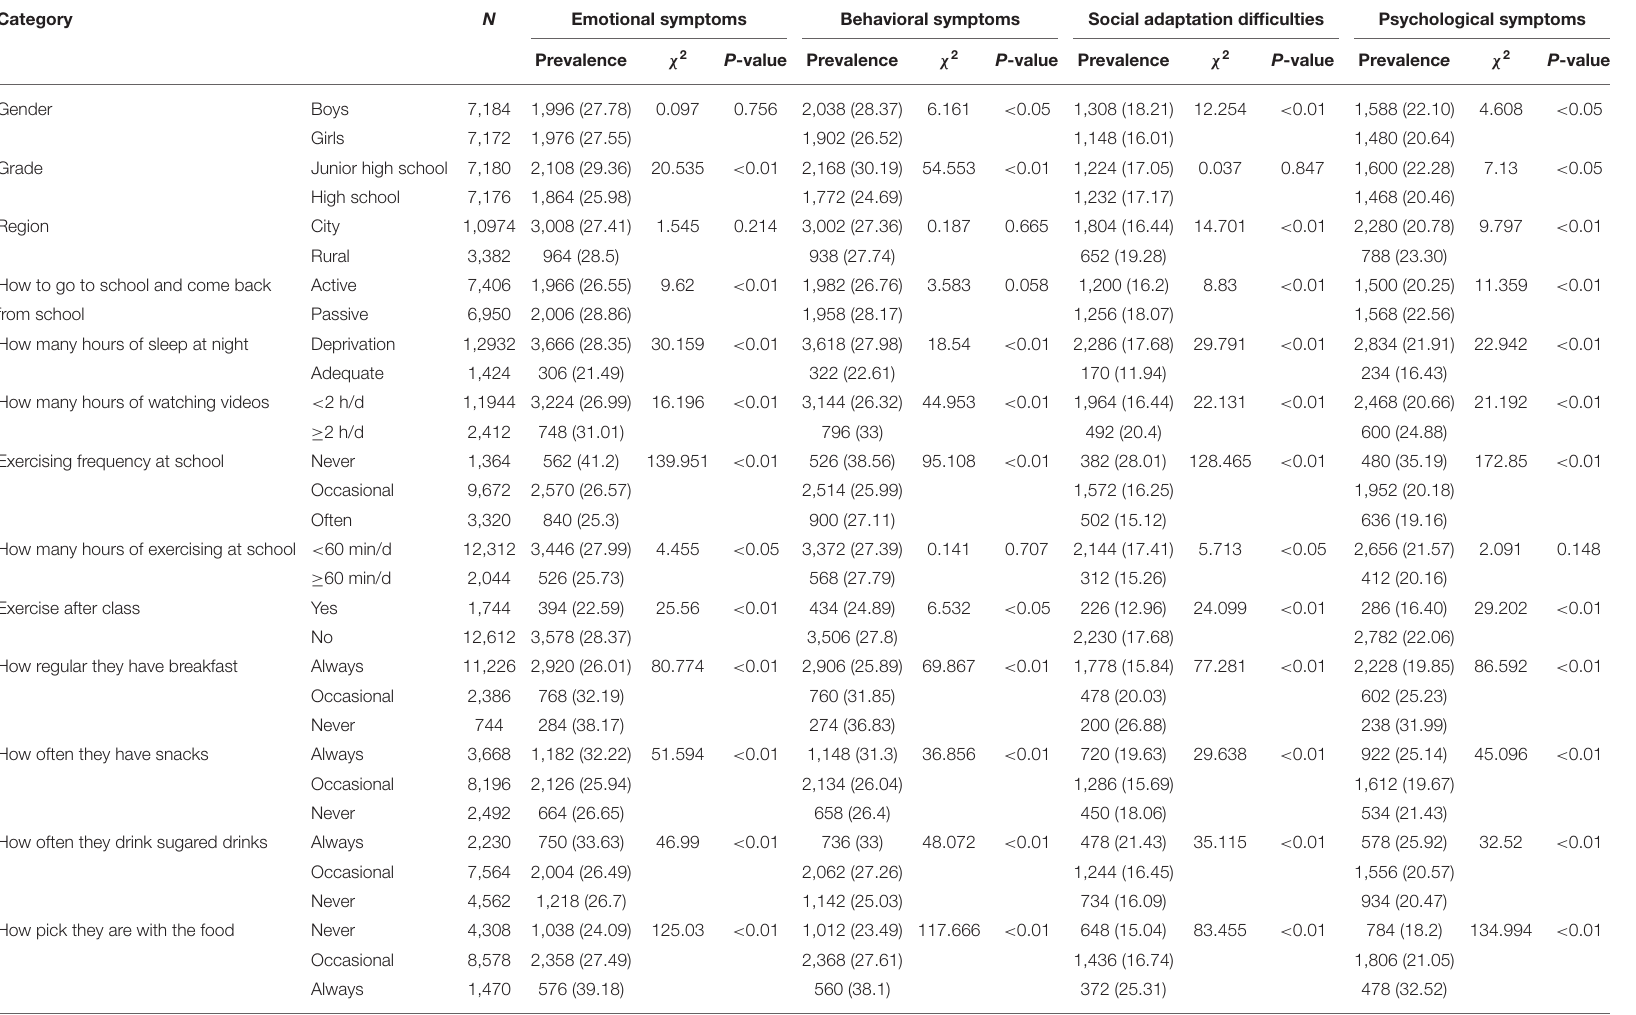
TABLE 1 | The comparison of detection rates of psychological symptoms with different lifestyles and for Chinese middle school students (%). Category N Emotional symptoms Behavioral symptoms